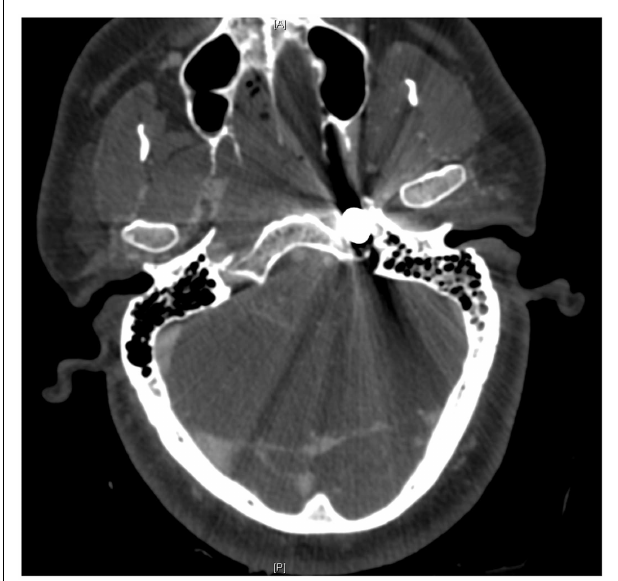
FIGURE 7 | Pre-operative CT scan showing complete transection of the petrous portion of the left internal carotid artery